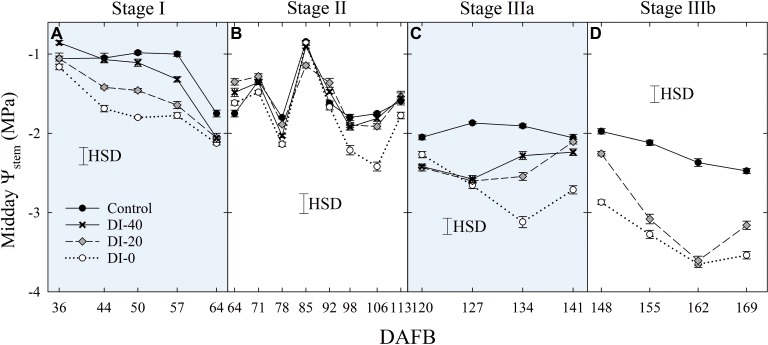
Midday stem water potential (Ψstem) at stages I (A), II (B), IIIa (C), and IIIb (D) of ‘September Bright’ nectarine fruit growth. Trees irrigated to 100% (control), 40% (DI-40), 20% (DI-20), and 0% (DI-0) of crop evapotranspiration. Timeline expressed in days after full bloom (DAFB). Error bars represent standard errors of means (n = 6). Significant differences determined with analysis of variance and Tukey’s honestly significant difference (HSD, p < 0.05).